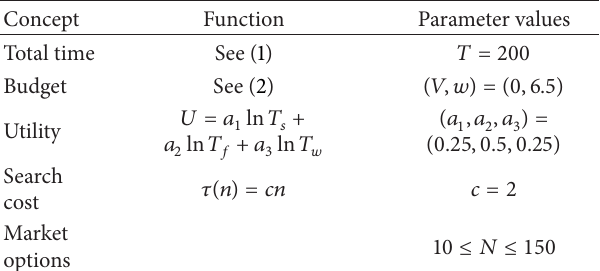
Table 1: Essential parameter